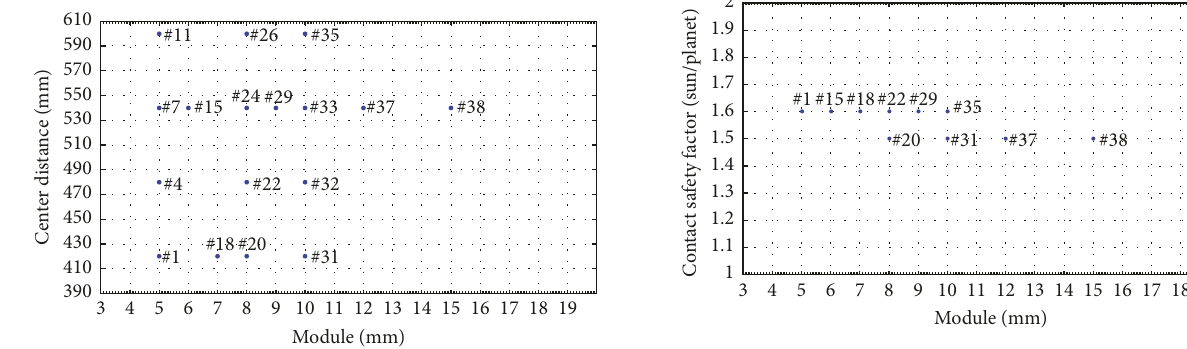
Figure 16: Safety factor on contact between sun and planet